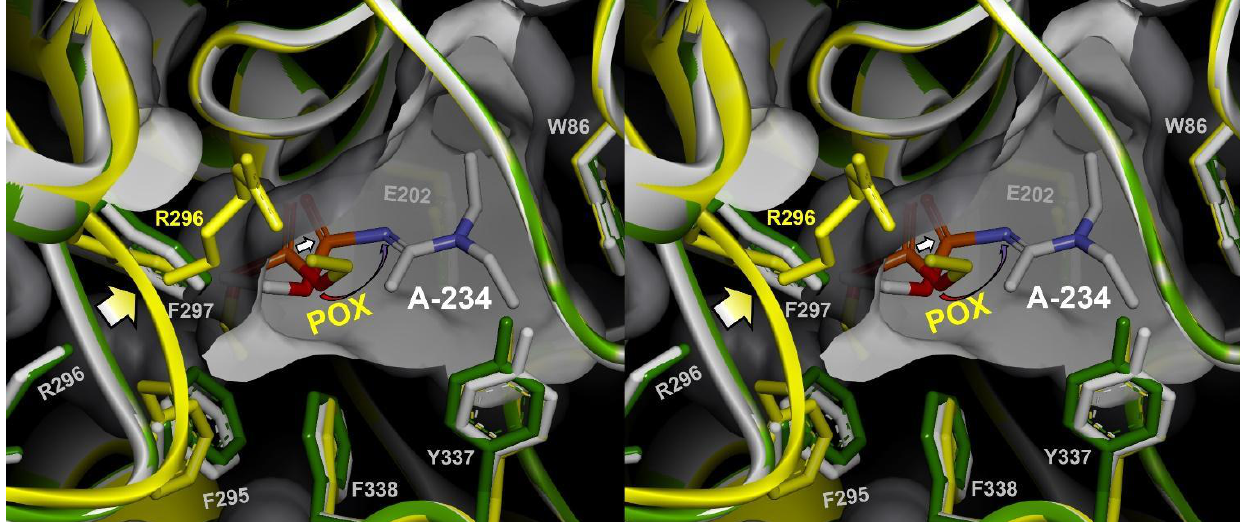
Figure 7. Stereo representation of PACCT 3 overlays of POX-hAChE (yellow ribbon and sticks) and A234-hAChE (grey ribbon and sticks) onto Apo-hAChE (green ribbon and sticks). Cut-off of the grey solvent accessible Connolly surface belongs to Apo-hAChE and illustrates internal volume of the hAChE active center gorge. Opening of the gorge is perpendicular to the plane of the paper. Arrows indicate 4.9 Å shift of the AP loop (yellow arrow), 1.2 Å shift of conjugated P atom (white arrow) and 2.4 Å shift of O to N atoms directly bound to P (red-blue curved arrow).